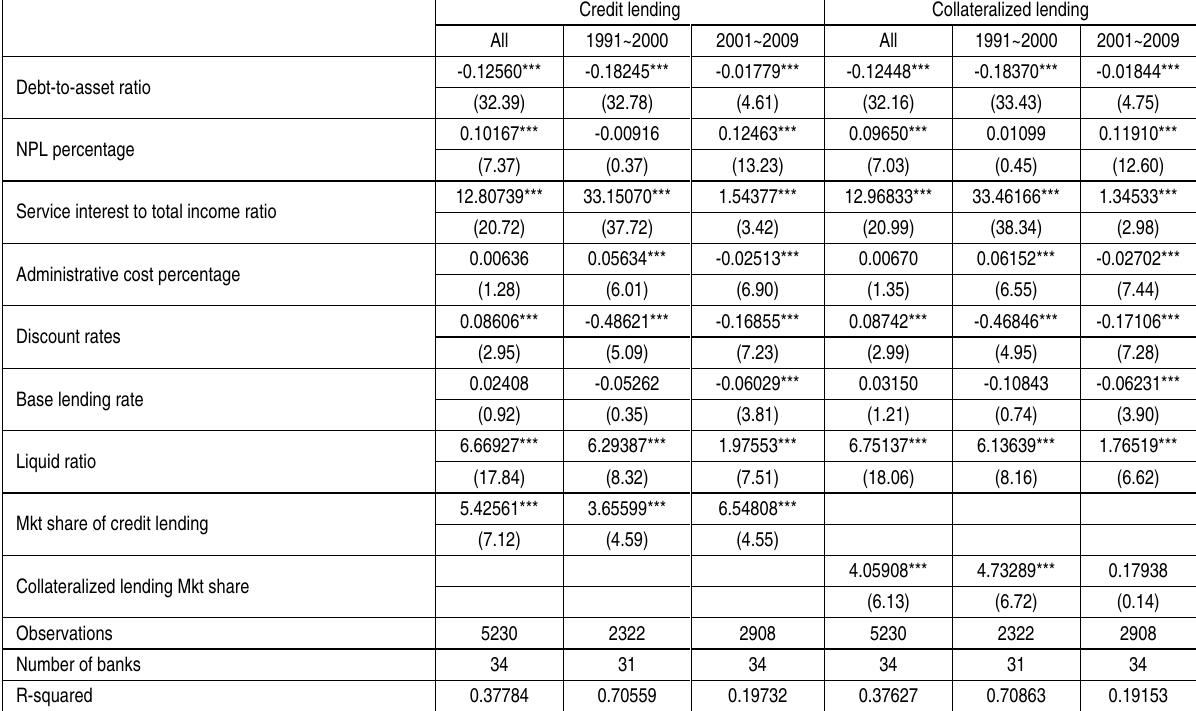
Table 5. Credit lending and collateralized lending market shares – base model